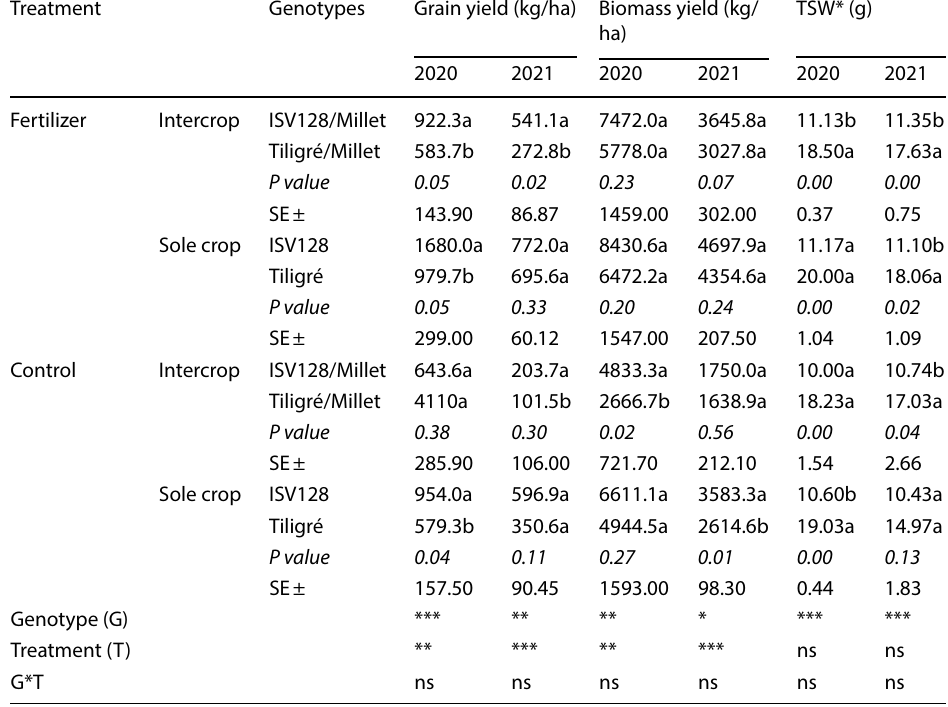
Table 2 Effect of intercropping and fertilizer microdosing on cowpea